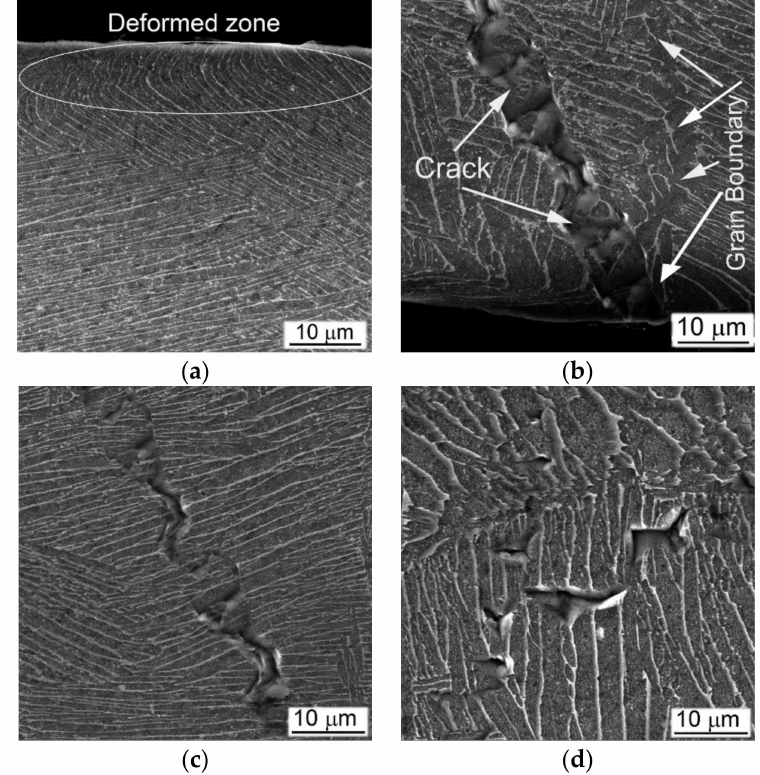
Figure 13. Microstructure of the Ti64LM specimen after SHPB test at the strain rate of 1390 s − 1 : ( a , b )—zone I, ( c )—zone II, ( d )—zone IV. SEM,